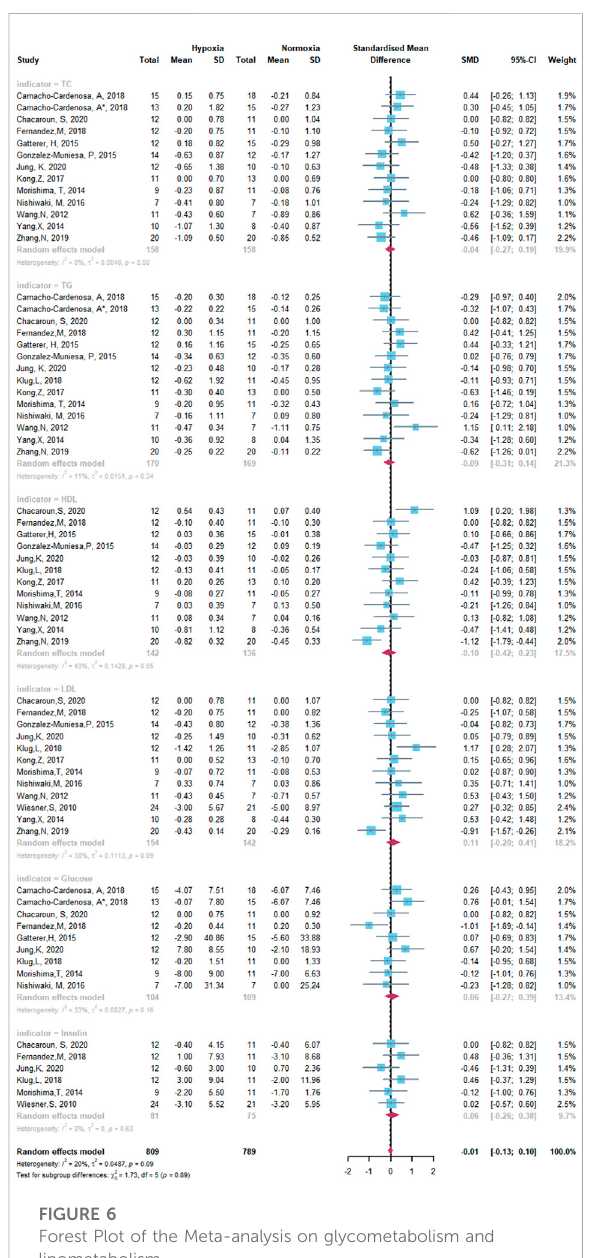
FIGURE 6 Forest Plot of the Meta-analysis on glycometabolism and